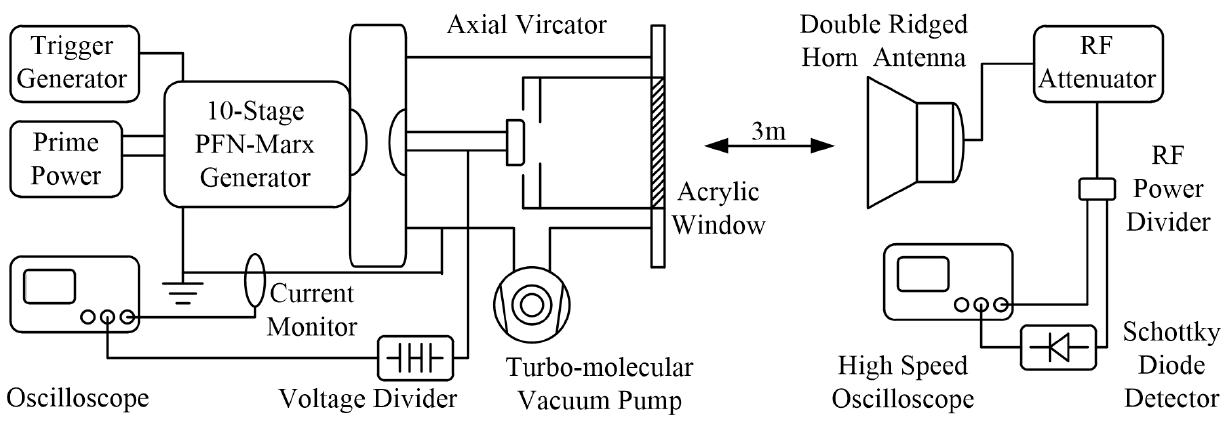
Figure 1. Schematic diagram of the experimental system.